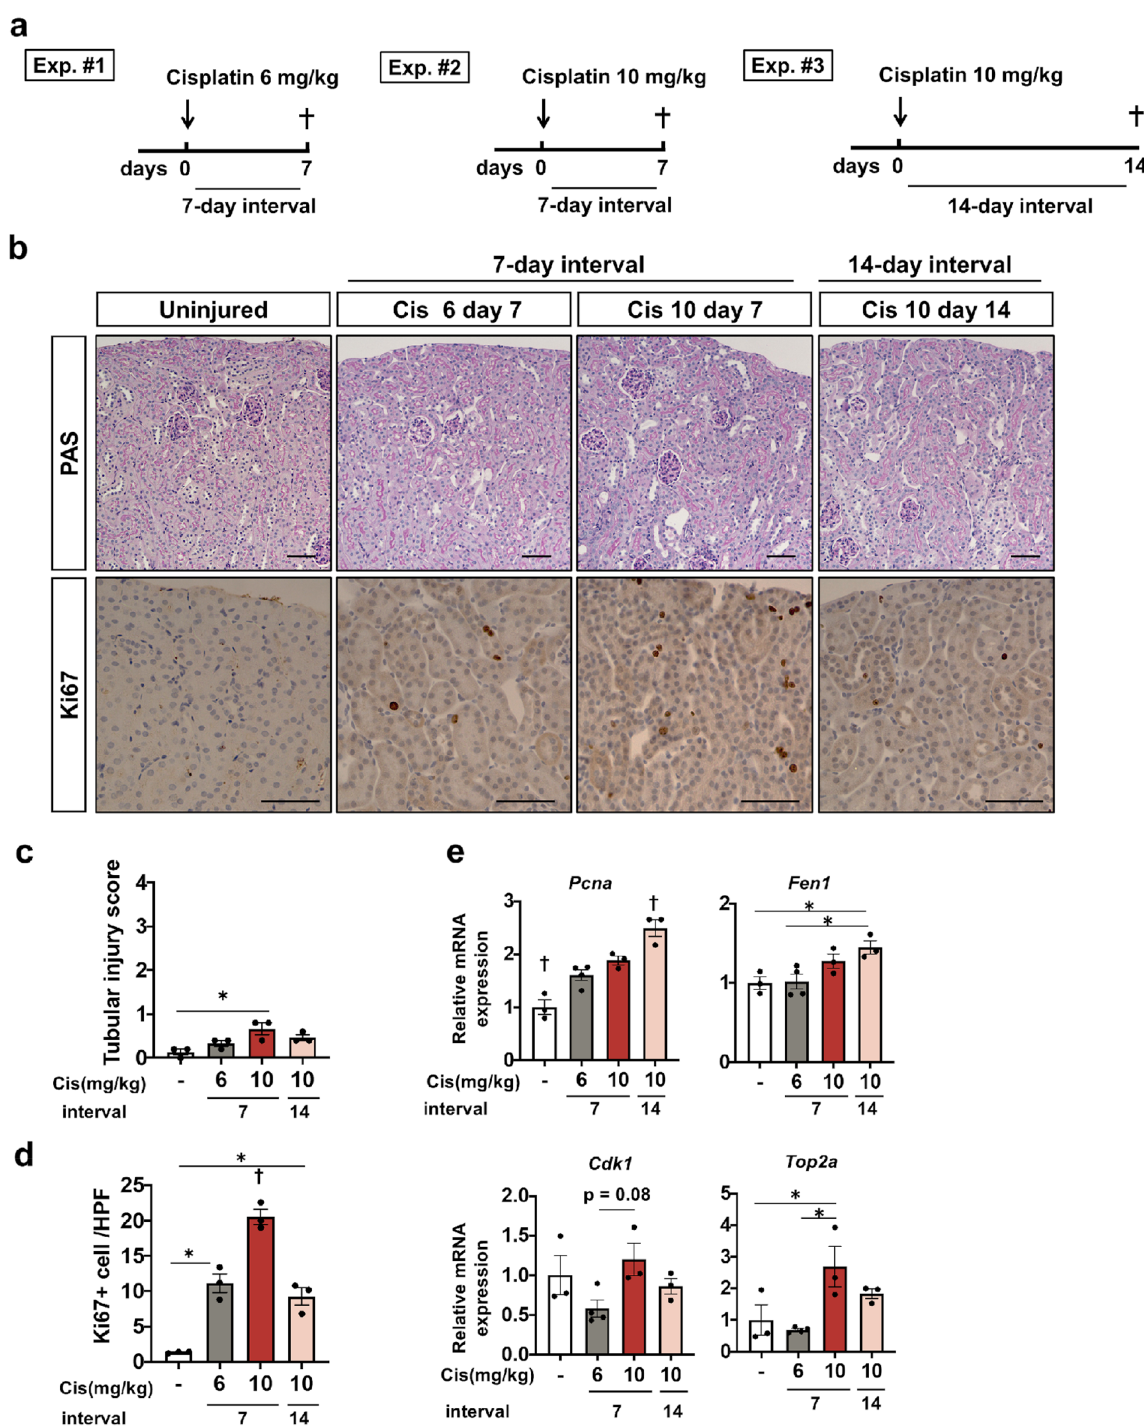
Figure 2. Assessment of repair and cell cycle state at seven or 14 days after a single cisplatin injection at a dose of 6 or 10 mg/kg. ( a ) Experimental scheme. A single dose of 6 mg/kg or 10 mg/kg of cisplatin was injected. The kidneys were assessed at seven or 14 days after the injection. ( b ) Histological analysis of the kidney. PAS staining, and immunostaining of Ki-67. ( c , d ) Quantification of the tubular injury score and the number of Ki-67 + tubules. ( e ) Quantitative PCR of whole kidneys for the cell cycle markers ( Pcna, Fen1 , CDK1, and Top2a ). Data are the mean ± SE. * P < 0.05, † P < 0.05 vs other groups. Scale bar = 100